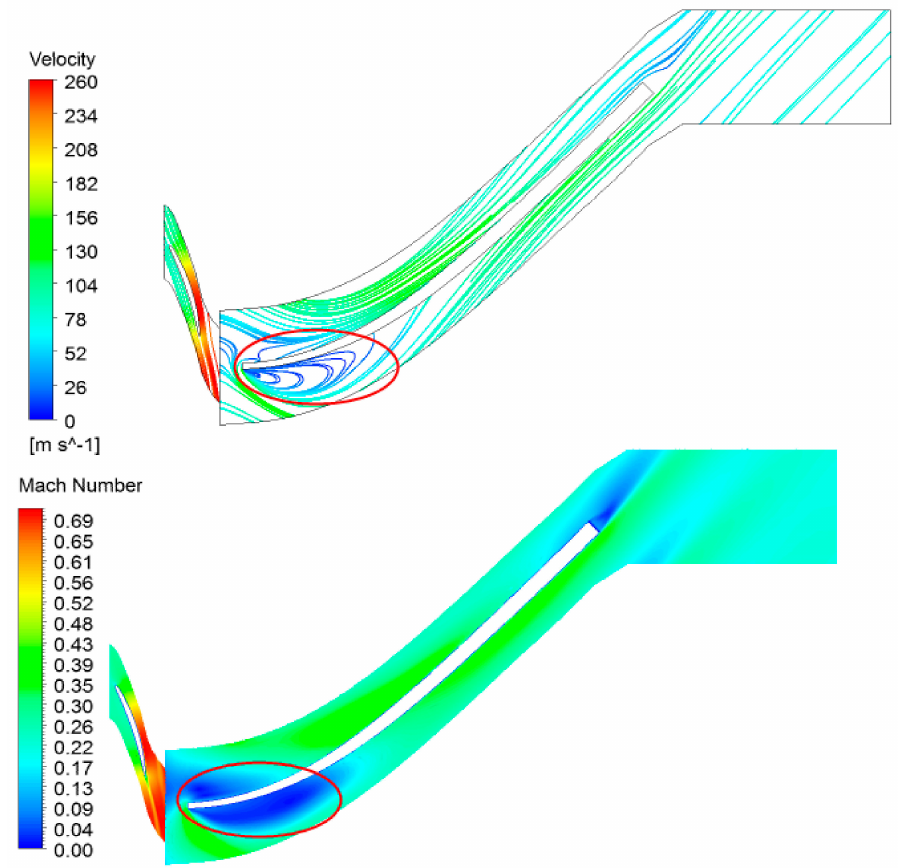
Figure 20. The streamline and Mach number contour at mid span for 65% of nominal rotational speed and PR ts =